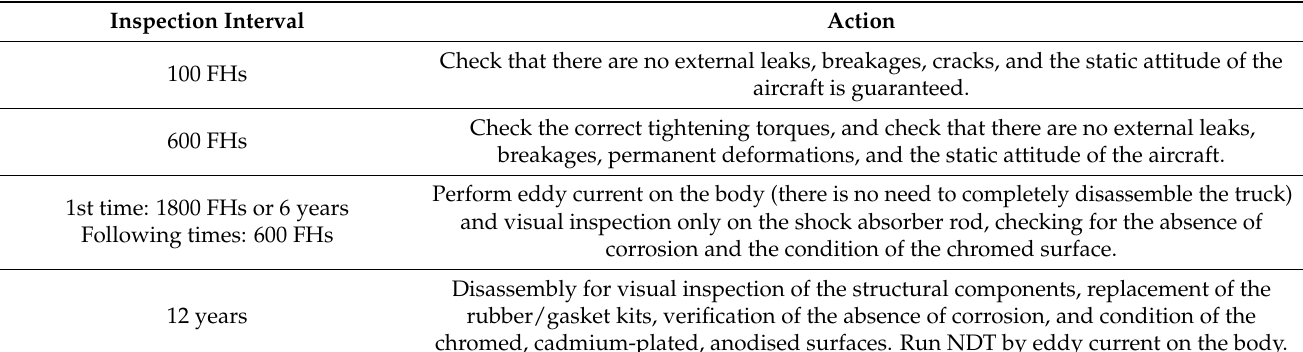
Table 12. Landing gear failure modes and suited detection approach